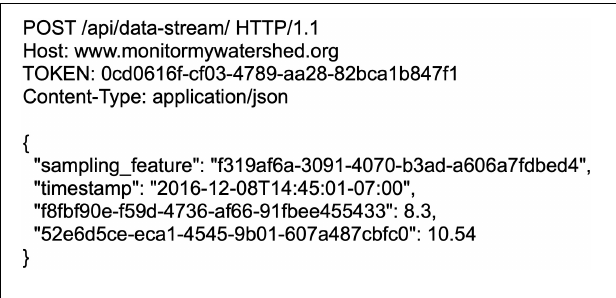
FIGURE 2 | Format of the HTTP POST requests sent to an instance of the Data Sharing Portal to post data. In this example, numeric values are specified for two measured